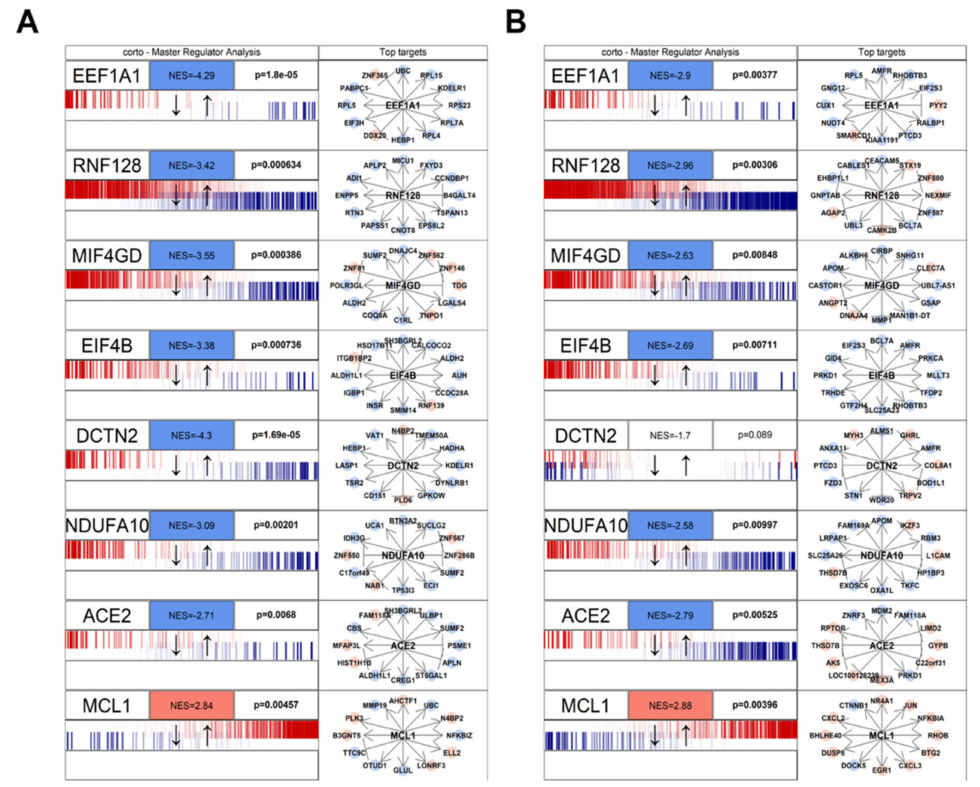
Figure 2. Master Regulator Analysis of the 8 human proteins in the human / SARS-CoV-2 interactome and most concordantly a ff ected by beta-coronavirus infection. The visualization was obtained through the mraplot function of the R CRAN package corto . In brief, for each analyzed network, the centroid is indicated by its gene symbol (e.g., EEF1A1, ACE2). The genes in each network (generated by the corto package from the GTEX healthy lung RNA-Seq dataset) are shown in a barcode-like diagram showing all transcriptome genes by means of their di ff erential expression upon viral infection, from most downregulated (left) to most upregulated (right). Positively- (red) and negatively- (blue) correlated targets are overlayed on the di ff erential expression signature as bars of a di ff erent color. Normalized Enrichment Score (NES) and p -value are also indicated. To the right, the 12 highest-likelihood network putative targets of each protein are shown, in red if upregulated, in blue if downregulated, with a pointed arrow if predicted to be activated by the centroid protein, and with a blunt arrow if predicted to be repressed. The figure shows two analyses based on the MERS infection signature ( A ) and on the SARS infection signature ( B ). Full results are available as Supplementary Table